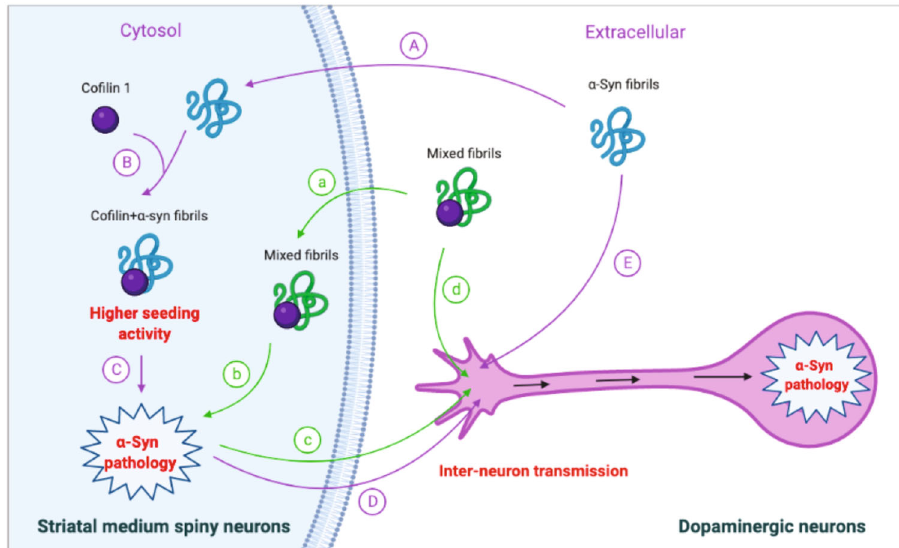
Fig. 7 Schematic diagram showing the effect of co fi lin 1 in α -syn pathology. Purple lines: overexpression of co fi lin 1 in the striatum promotes the spreading of α -syn pathology. ( A ) Injected α -syn fi brils are taken up by the striatal medium spiny neurons. ( B ) Co fi lin 1 in the medium spiny neurons interact with α -syn fi brils and enhances its seeding activity. ( C ) α -Syn fi brils seed endogenous α -syn into aggregates. ( D ) Pathogenic α -syn aggregates transfer from the medium spiny neurons to the dopaminergic terminals and spread along the neurites to the SN, inducing pathological α -syn inclusions in dopaminergic neurons. ( E ) α -Syn fi brils are taken up by dopaminergic terminals and spread to dopaminergic neurons in the SN. Green lines: injection of co fi lin 1- α -syn mixed fi brils causes α -syn pathology. a Co fi lin 1- α -syn mixed fi brils are taken up by striatum medium spiny neurons. b Mixed fi brils cause α -syn pathology in the striatum. c Striatal pathogenic α -syn transmit to dopaminergic neurons in SN, causing neuronal damage. d Mixed fi brils are directly transferred to SN through the terminals of dopaminergic